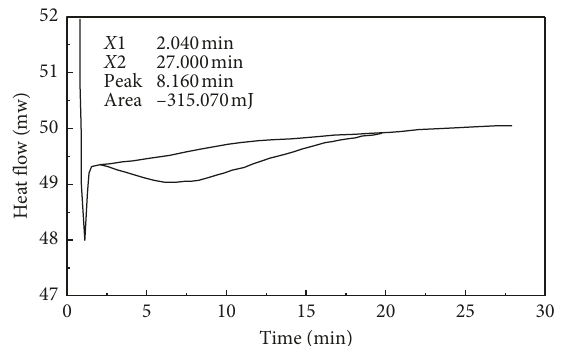
Figure 5: Cement protoplasmic DSC curve under the condition of 35 ° C.